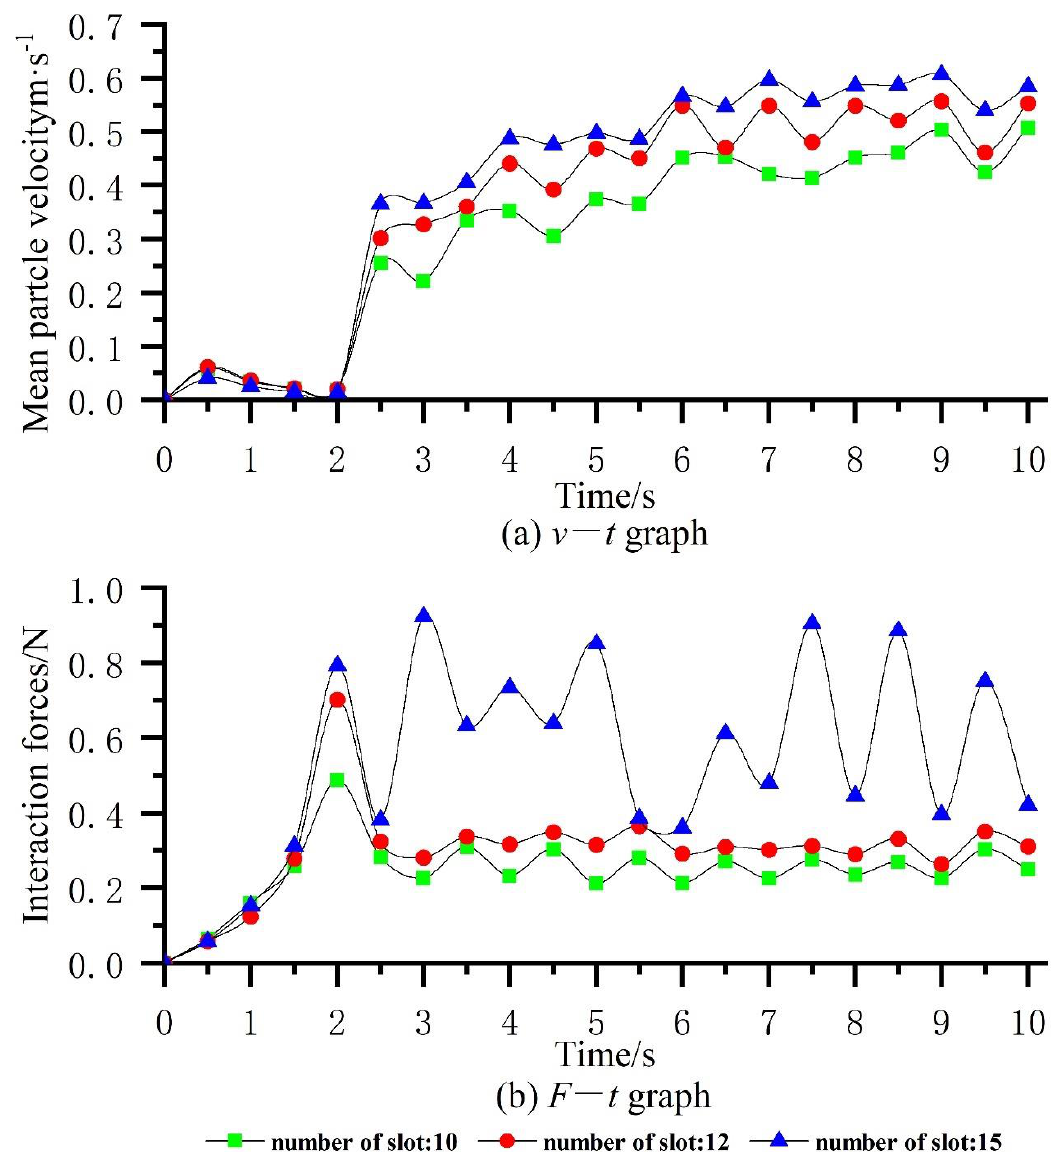
Figure 12. Average velocity and interaction force curves of tea particles at different numbers of pot